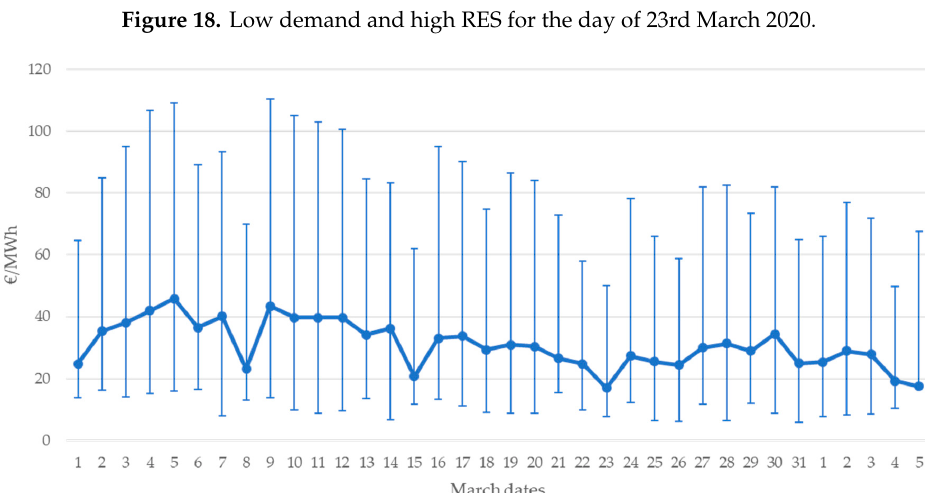
Figure 19. Average, min and max (error bars) price of energy in the IPEX. Dates 1st–28th March 2020.